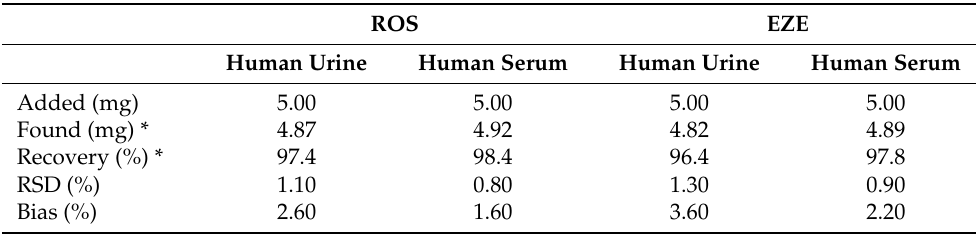
Table 2. Recovery results obtained from the analysis of ROS and EZE in human urine and serum samples by AdSDPV method in 0.1 M H 2 SO 4 (stripping conditions: accumulation potential of 0.0 V and accumulation time of 15 s). ROS EZE Human Urine Human Serum Human Urine Human